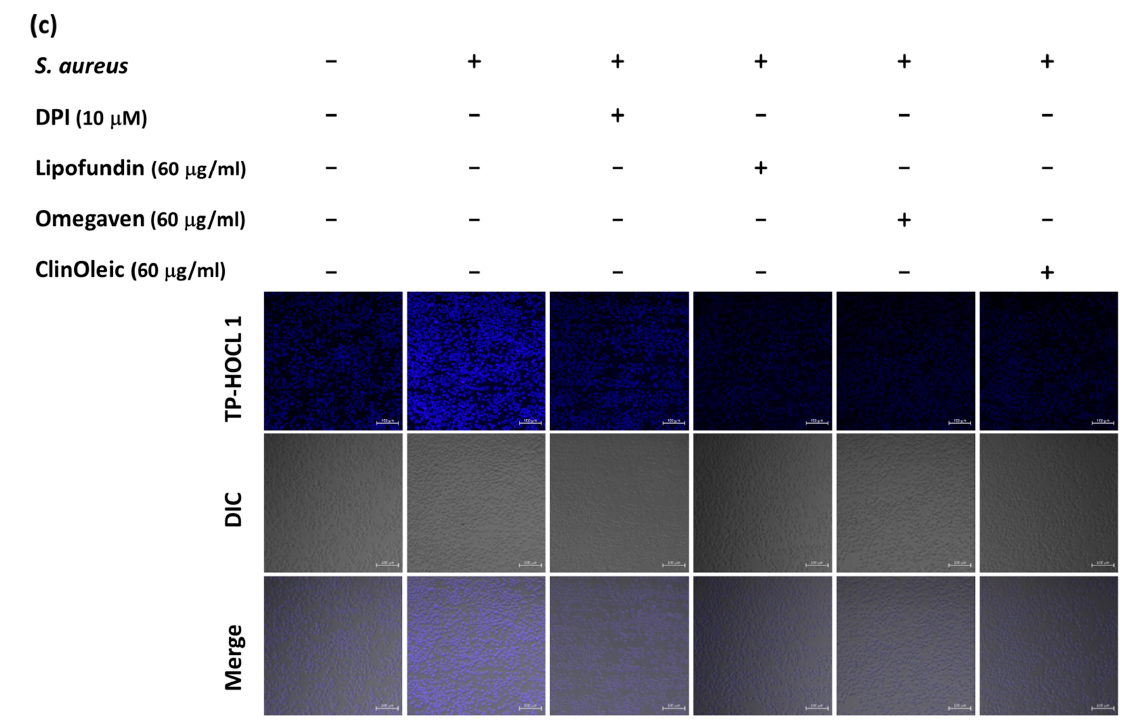
Figure 2. Three lipid emulsions inhibited ROS production and intracellular HOCl. Mouse RAW264.7 cells were treated with or without lipid emulsions prior to and during S. aureus infection. ( a ) The time kinetics of the total ROS in S. aureus -infected RAW264.7 cells were detected by luminol chemiluminescence assays. ( b ) The relative fold changes were the net luminescence value induced by co-incubation with the indicated agents and bacteria divided by the luminescence stimulated by S. aureus . The means ± SD of the three experiments are given. * = A significant difference compared with the S. aureus -infected control. # = A significant difference between the treatments with Lipofundin and Omegaven. ( c ) Intracellular HOCl stained by BioTracker TP-HOCL 1 live cell dye. Diphenyleneiodonium chloride (DPI, 10 µ M) was used to block ROS production as a negative control. Fluorescent images were taken by confocal microscopy with a 10 × objective. The scale bar is 100 µ